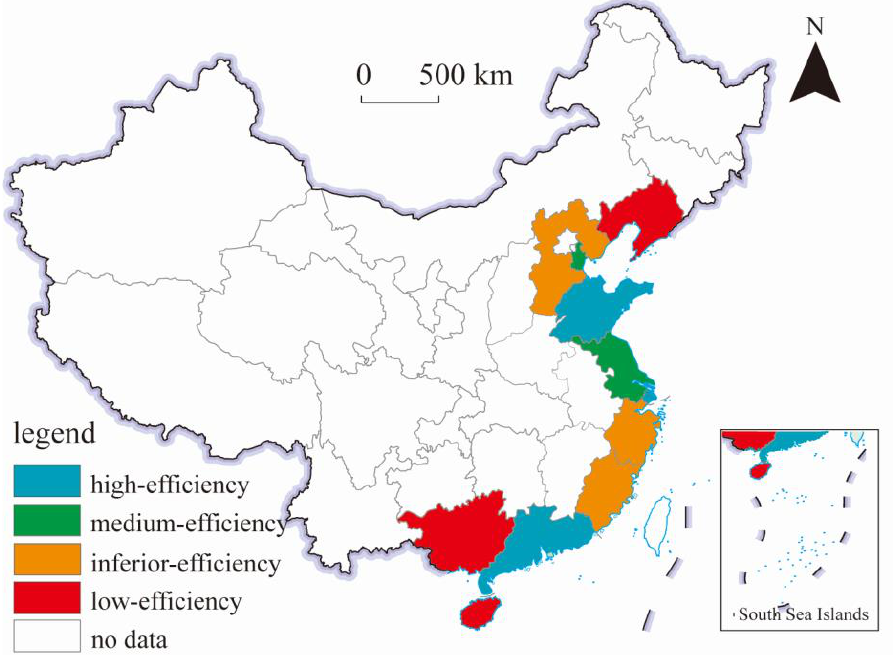
Figure 2. Spatial distribution of SUE in coastal areas of China. Note: The map above is made from the base map downloaded from the standard map service website of the National Bureau of Surveying, Mapping, and Geographic Information with the review number GS (2019)1825.